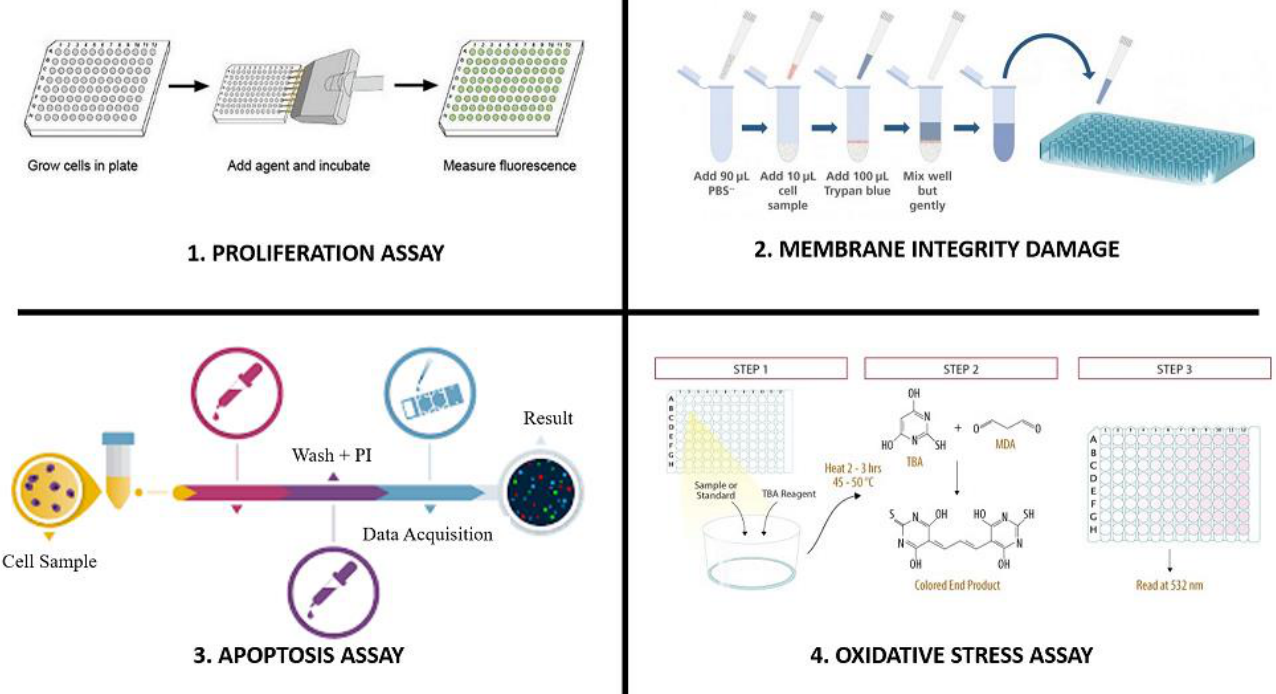
Figure 2. Conventional methods of evaluating the cytotoxicity of the nanoparticles.